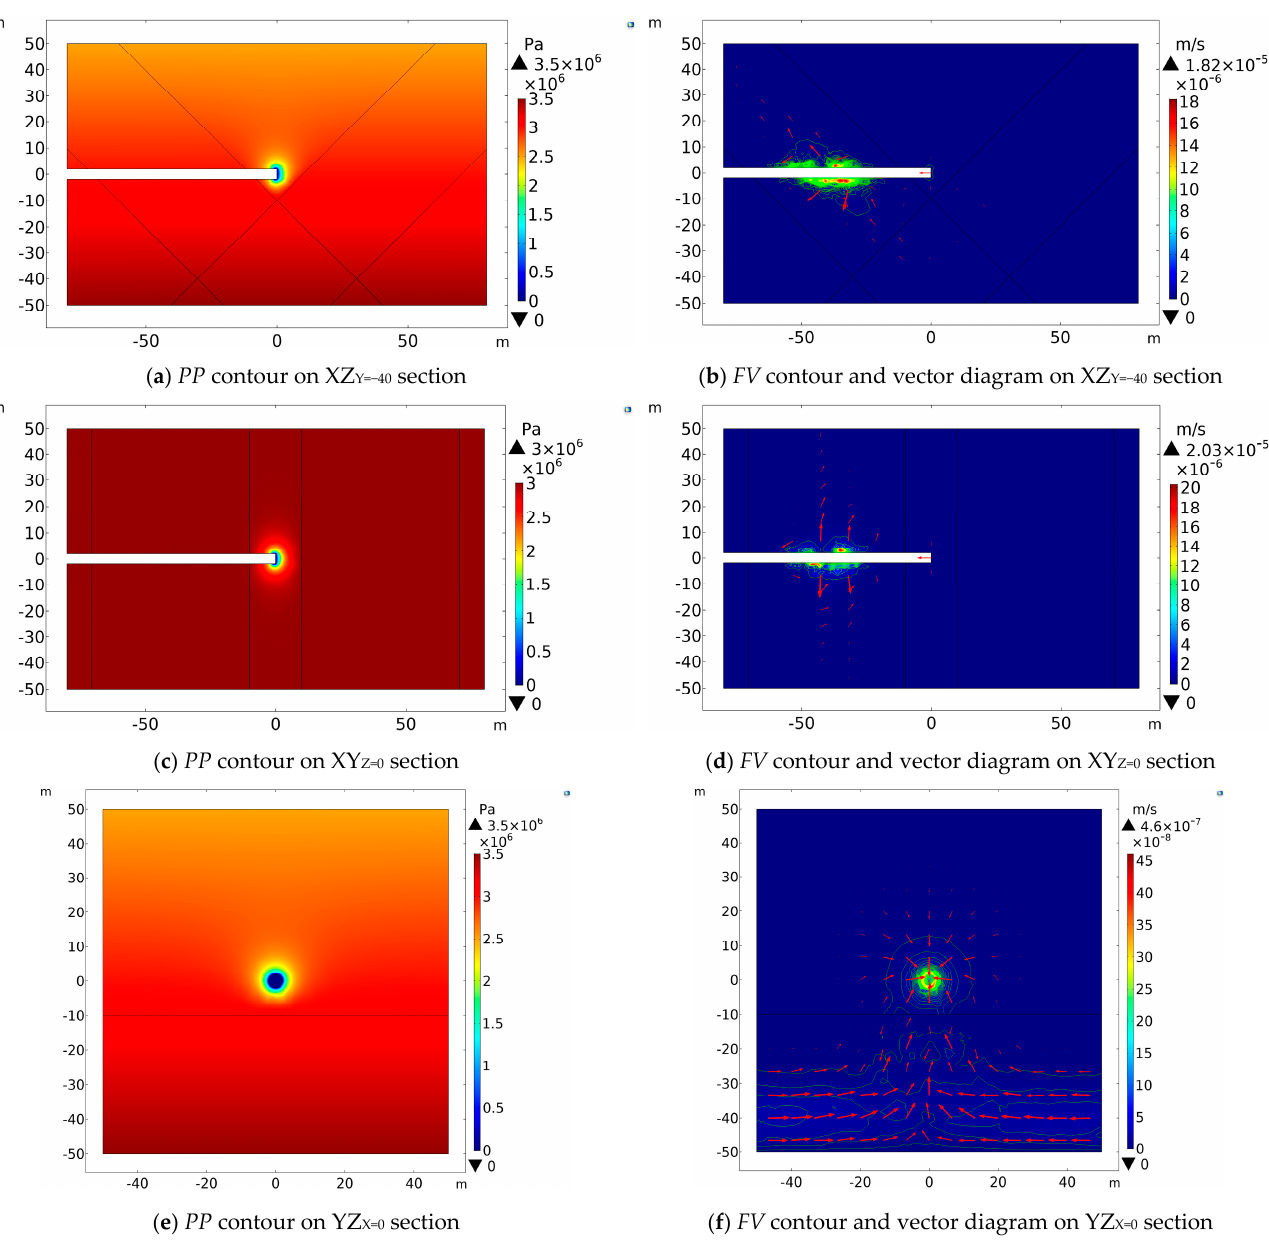
Figure 10. Simulation results for the case Y = − 40 m. The PP contours in Figure 10a,c,e all show a low-pressure region near the